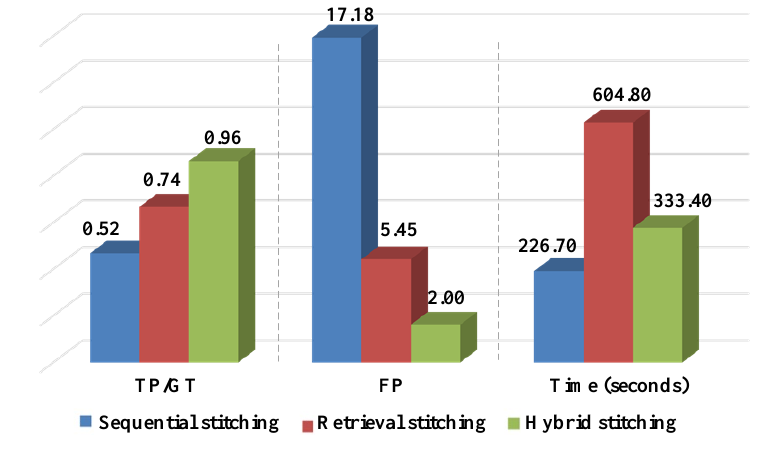
Figure 5. Comparison results of average performance on 24 VIRAT